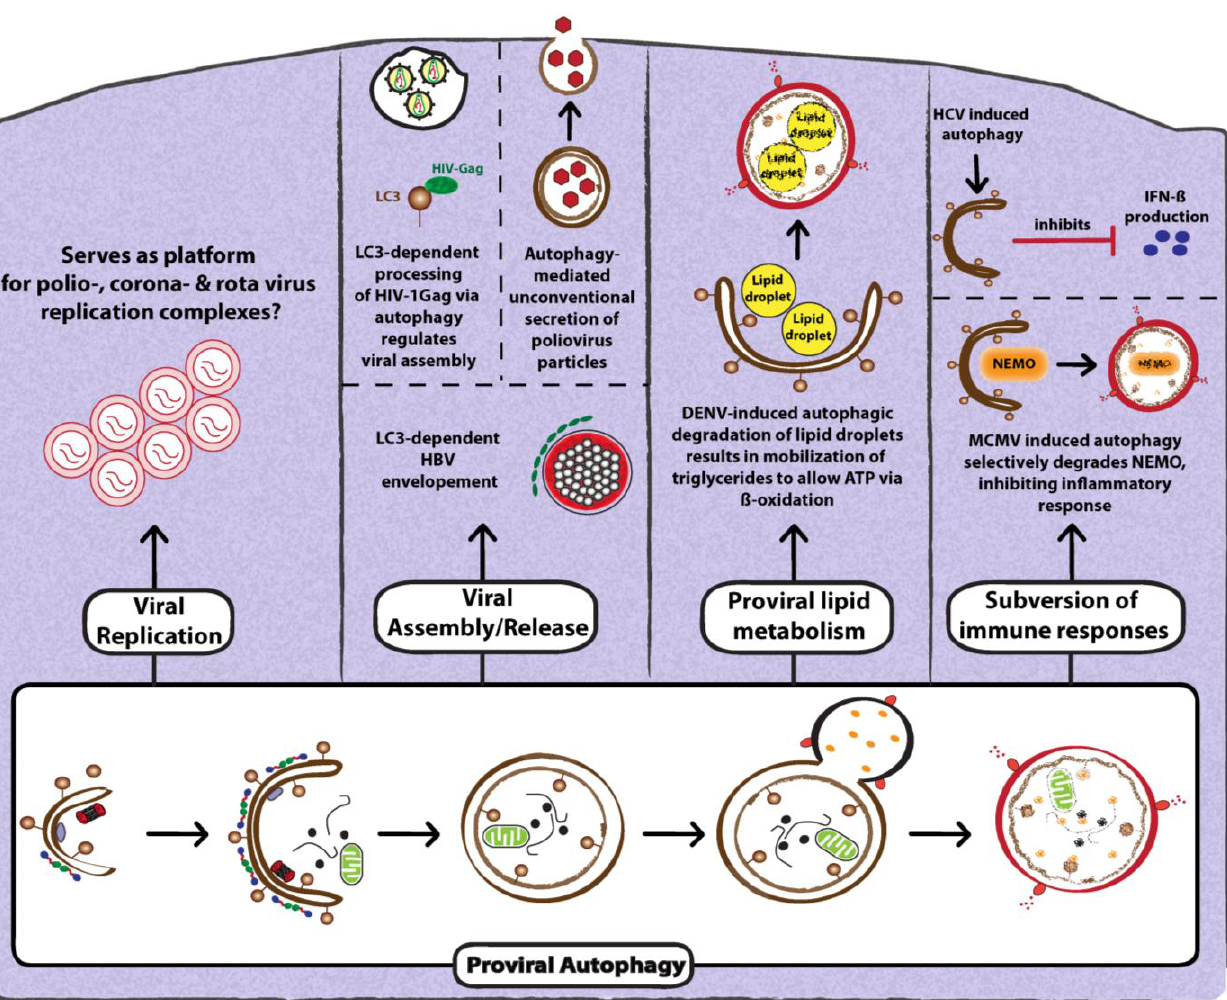
Figure 4. Proviral functions of autophagy. Autophagy is known to exert diverse proviral functions during viral infection. Autophagosomes have been proposed provide a membrane platform for viral replication complexes or to mediate virus assembly and release. Furthermore, viruses can trigger selective autophagy to degrade either lipids (lipid droplets) for energy production during viral replication or to subvert immune responses by selectively degrading key regulatory molecules. The mechanistic details related to proviral functions of autophagy are discussed in the